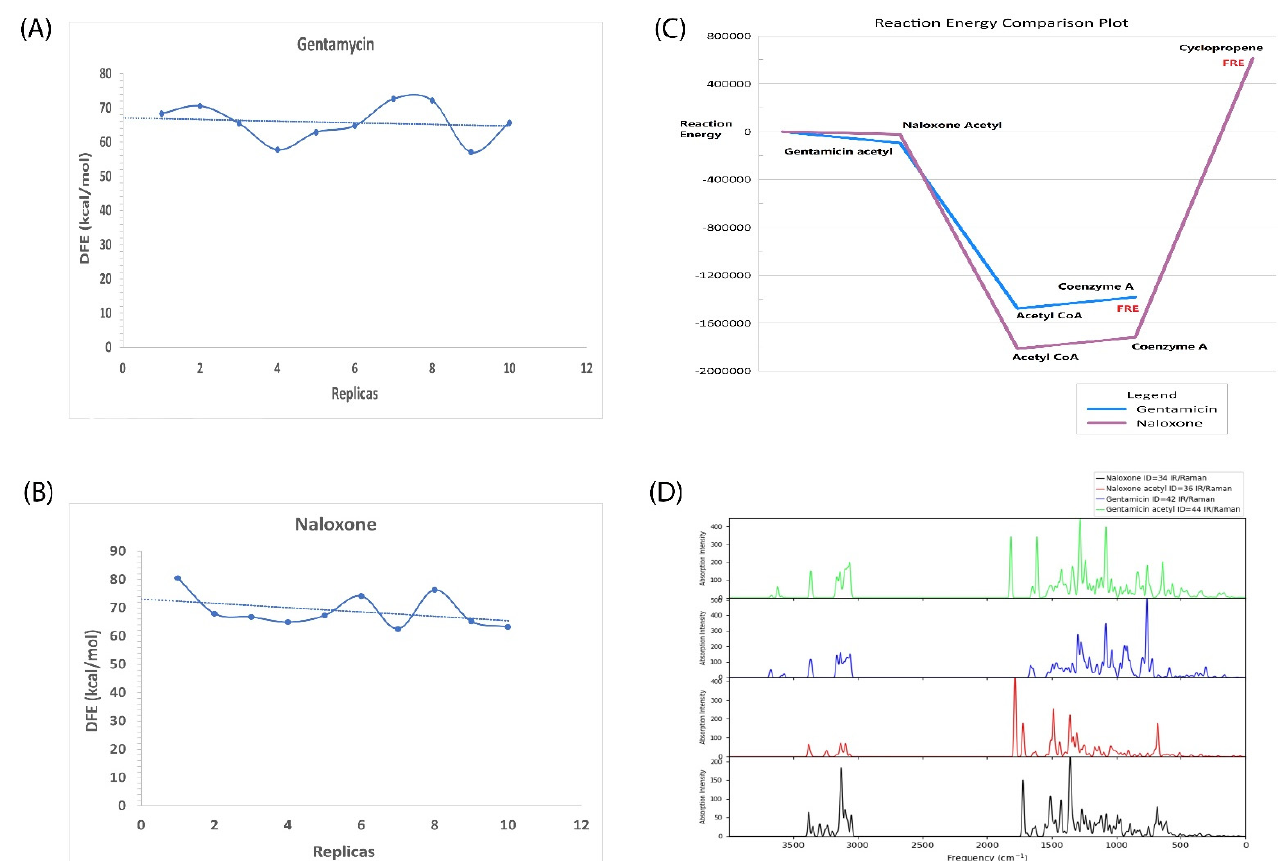
Figure 4. Reaction energies and unbinding energy profile. ( A ) The dissociation free energy (DFE) values of gentamicin for each replica simulation study are shown. ( B ) The dissociation free energy (DFE) values of naloxone for each replica simulation study are shown. The trendline is shown in a dotted blue line. ( C ) The reaction energy profile of each of the reactants and products formed is plotted with in-text mentions for each of them. The final reaction energy (FRE) is in red. The reaction profile of gentamicin is highlighted in dark purple and naloxone in blue. The x-axis consists of energy values in cal/mol. ( D ) The IR spectra of naloxone, naloxone acetyl, gentamicin, and gentamicin acetyl are shown in black, red, blue, and green, respectively. The x-axis denotes frequency/cm with absorption intensity in the y-axis.